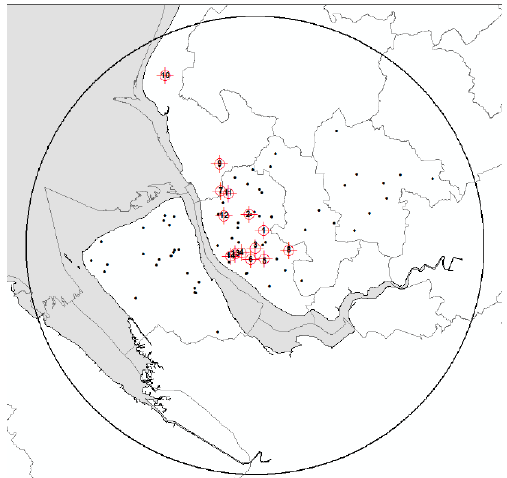
Figure 1. Locations of schools invited to participate in the workshops located within Merseyside. The schools selected for the sample (highlighted) were limited to contrasting areas within the city of Liverpool. The outer circle demarcates the geographic scope for statistical sampling (radius=25